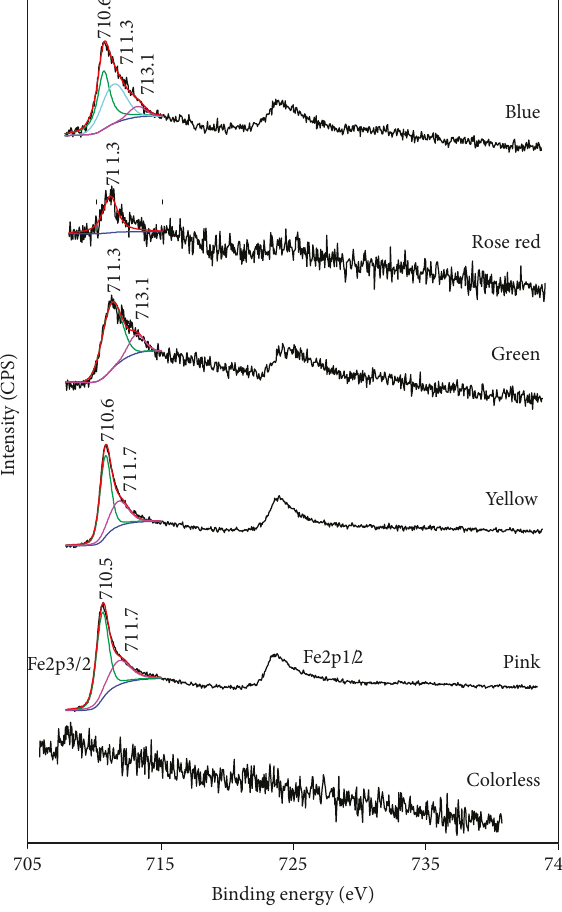
Figure 3: XPS spectra for Fe2p.